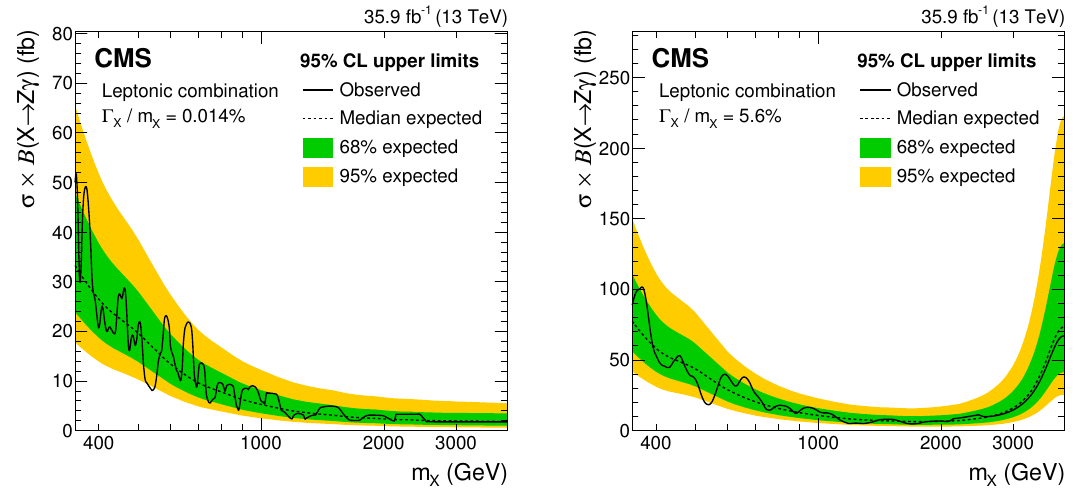
Figure 4 . Observed (solid) and expected (dashed) 95% CL upper limits on (cid:27) (X ! Z (cid:13) ) as a function of signal mass m X , together with the 68% (green) and 95% (yellow) CL ranges of the expected limit for the background-only hypothesis, for the combination of the ee (cid:13) and (cid:22)(cid:22)(cid:13) channels for (left) narrow and (right) broad spin-0